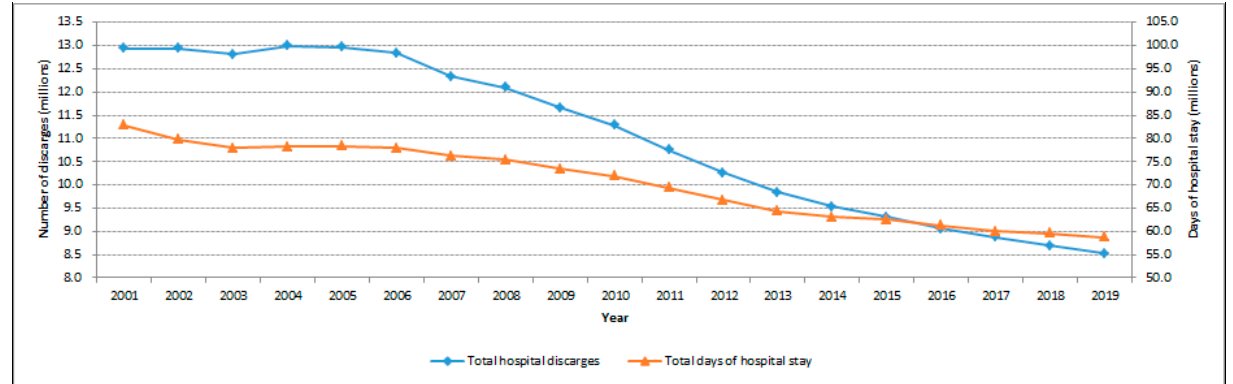
Figure 1. Italian trend of the overall volume of hospital discharges and days of hospital stay. Source: Italian Ministry of Health [2].